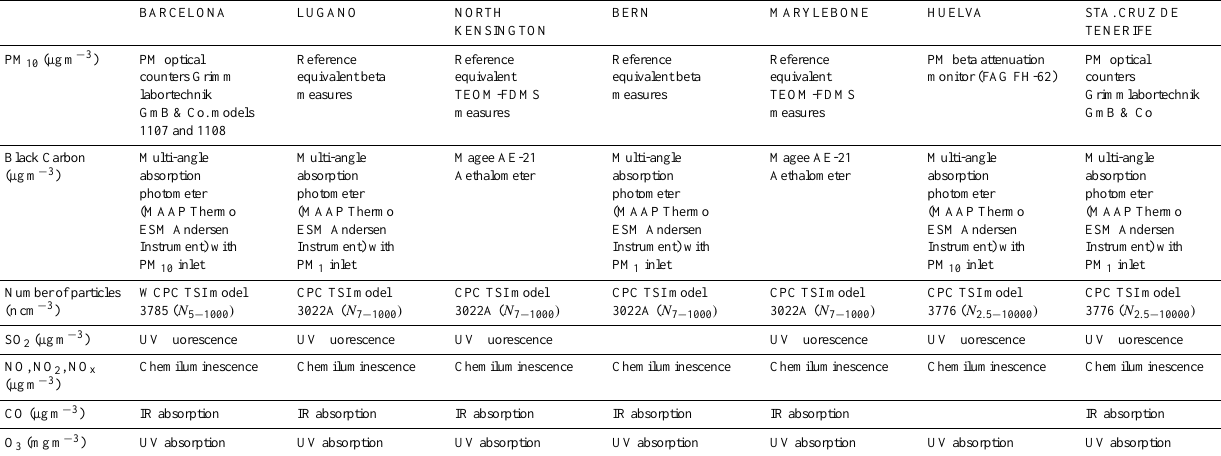
Table 3. Data from the air quality instrumentation working during the sampling period. BARCELONA LUGANO NORTH BERN MARYLEBONE HUELVA KENSINGTON